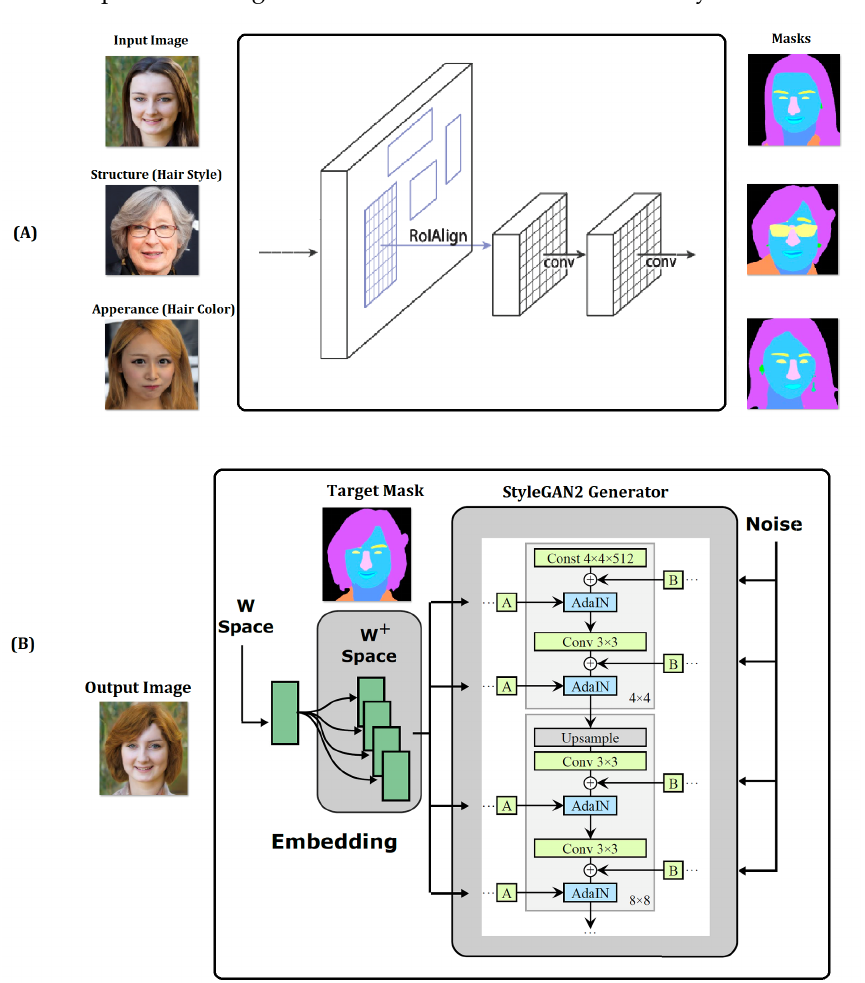
Figure 1. Architecture of our system ( A ) Face Segmentation Mask ( B ) Generative Hairstyle